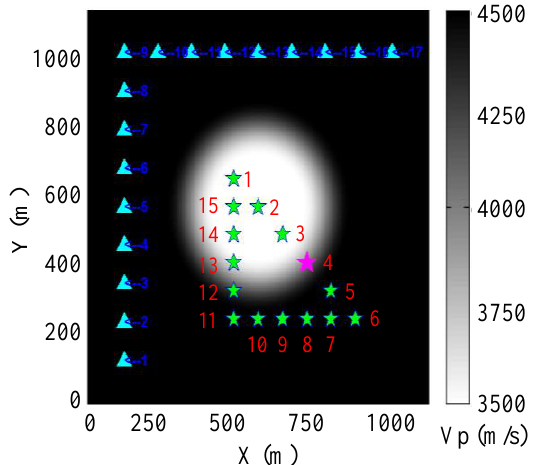
Figure 2. Synthetic test model for the Gaussian beam reverse-time migration (GBRTM) location method. The grey colorbar shows the velocity value of the test model. Here, only the 2D model with a low-velocity anomaly is illustrated, and the model with a high-velocity anomaly has the same structural shape, and the only difference is that the low-velocity anomaly (3500 m/s) is replaced by the high-velocity anomaly (5500 m/s); Cyan triangles and green stars separately indicate locations of sensors and sources. The red numbers correspond to the id of the sensors and test events.